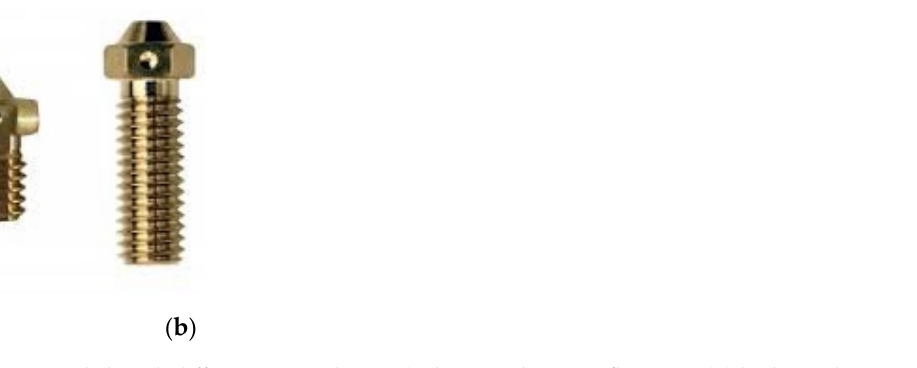
Figure 2. Nozzle length difference according to ( a ) lower volumetric flow rate, ( b ) higher volumetric flow rate.